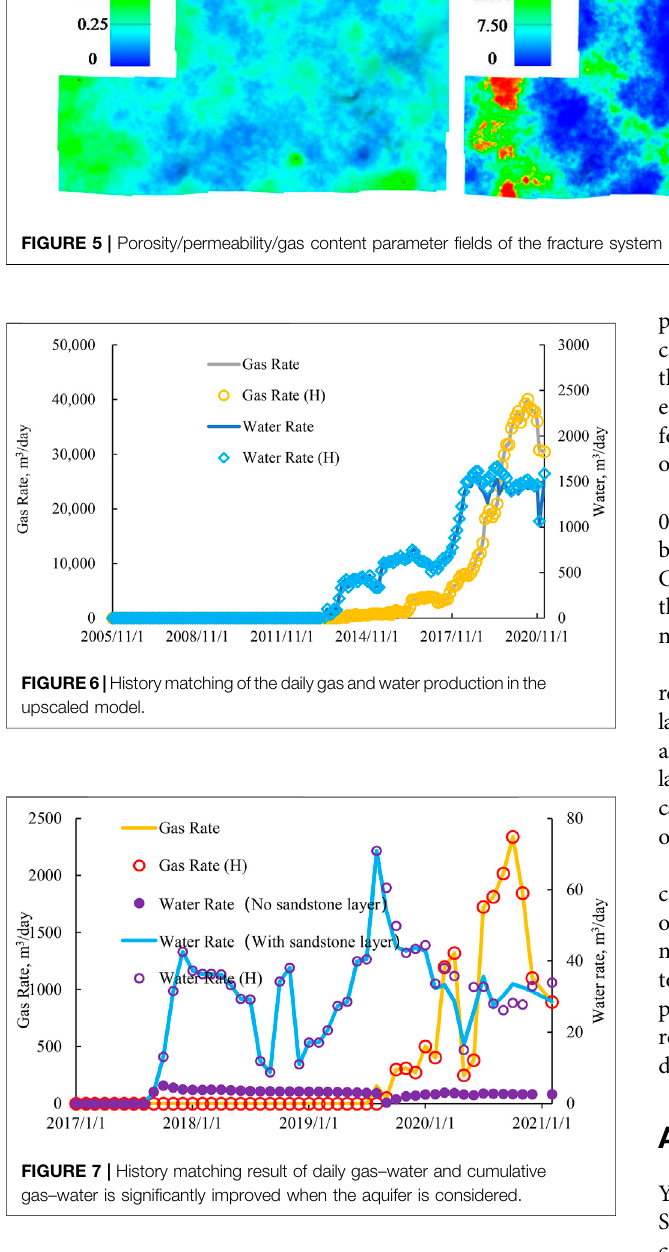
Frontiers in Energy Research |